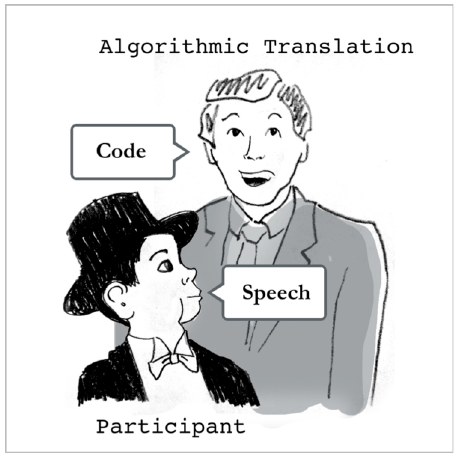
Figure 9 | Ventriloquism diagram for